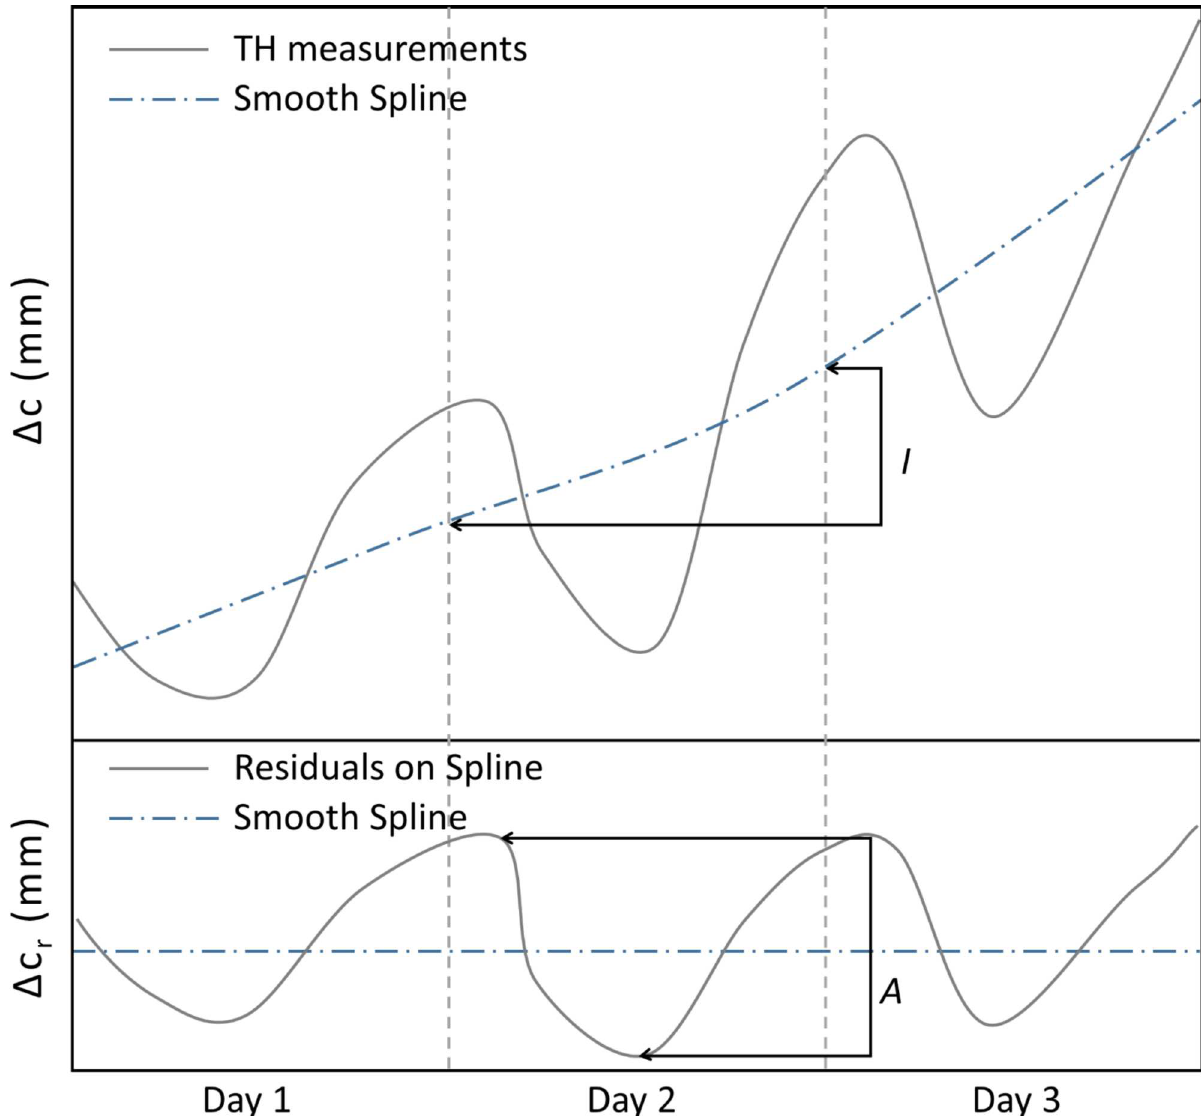
Fig 2. Schematic diagram illustrating metrics of tree circumference change. Shown are the most commonly observedpattern of dynamics in tree circumference change ( Δ c ) and how these are analyzedto calculatedaily circumference increment ( I ), residualvariation ( Δ c r ), and daily amplitude( A